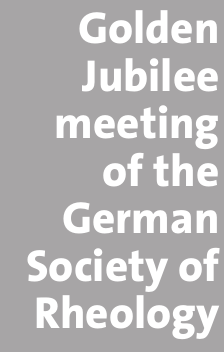
Figure 4: Relative viscosity function for the blend sys- tem C3C2 ( F t =